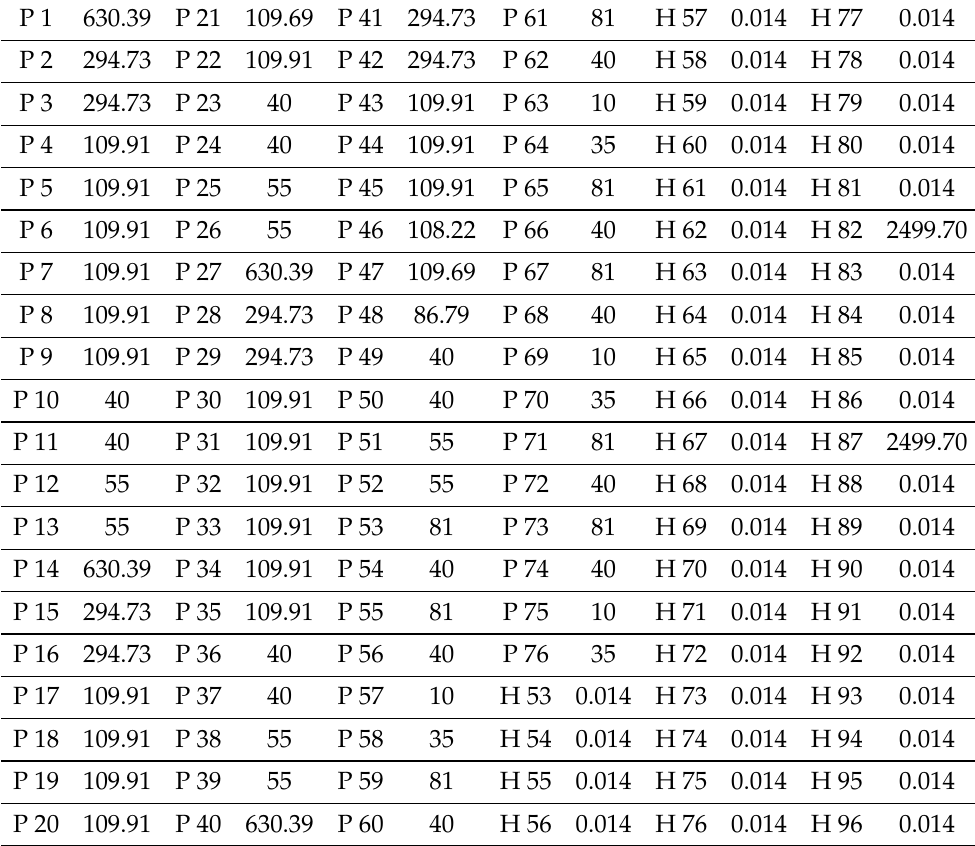
Table 14. Optimal schedule for the best cost obtained for Case study 6.